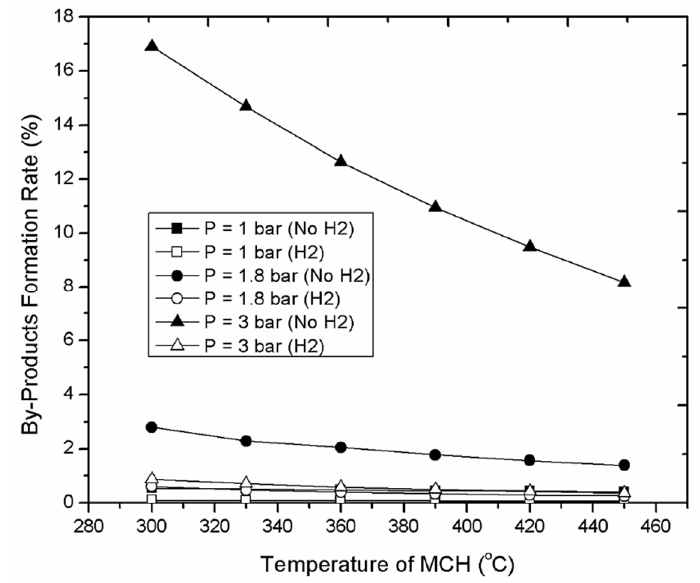
Figure 6. Effect of change in feed operating conditions on the byproducts’ formation. Figure 6. E ff ect of change in feed operating conditions on the byproducts’ formation.